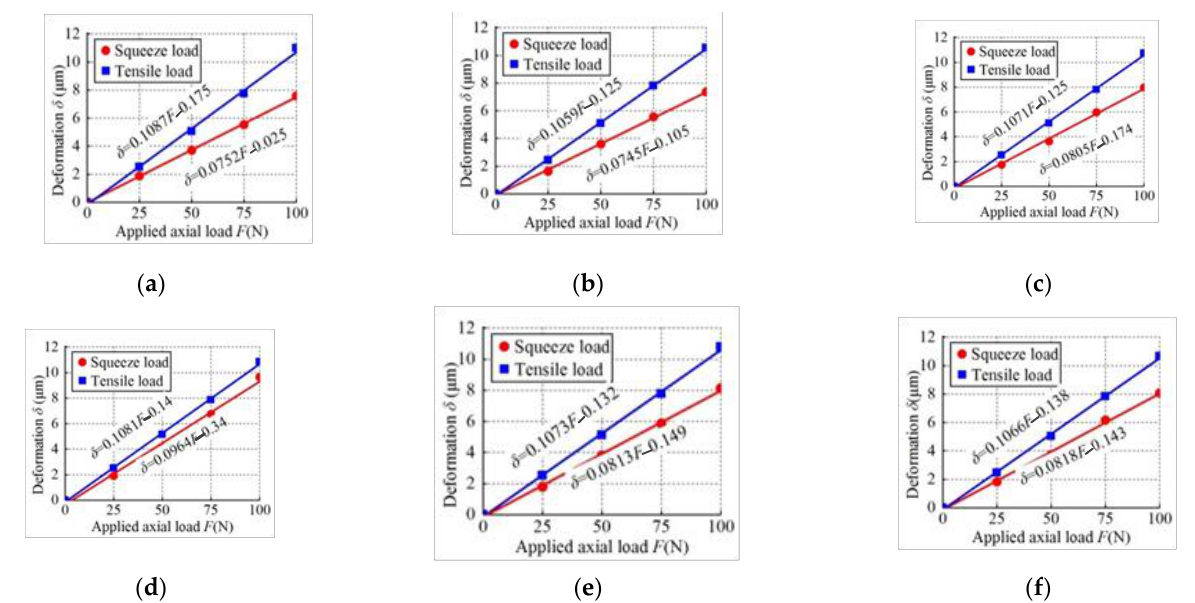
Figure 14. Results of stiffness testing of the RR-R-RR serial subchains: ( a ) Subchain 1; ( b ) Subchain 2; ( c ) Subchain 3; ( d ) Subchain 4; ( e ) Subchain 5; ( f ) Subchain 6.